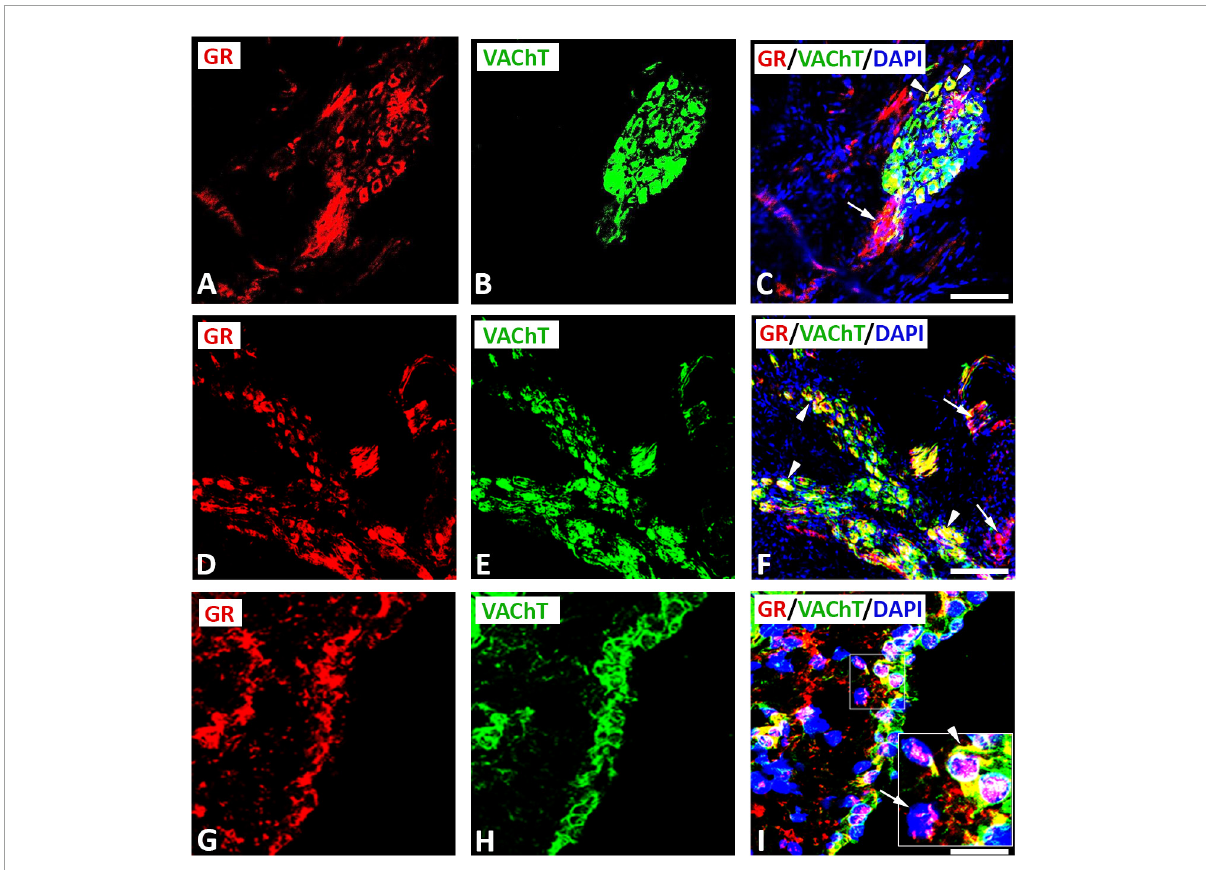
FIGURE2 Confocal microscopy of GR (A,D,G) ( red fluorescence ) and parasympathetic neuronal marker VAChT (B,E,H) ( green fluorescence ) double immunofluorescence in intracardiac ganglia (A–I) . (A–F) Show GR co-expressed with VAChT ( yellow fluorescence ) in large diameter neuronal soma (arrowhead), however, cluster of small diameter neuronal somata expressed GR only (arrow). (G–I) Higher magnification of gelatin-embedded transverse sections of atria (10 µ m thickness). Note a clear localization of GR immunoreactivity with VAChT-immunoreactive neuronal soma; however, some neurons expressed GR or VAChT only. The insert in (I) represents a higher magnification of a selected area showing GR expression in a nucleus (arrowhead) or at the periphery of neuron (arrow). (C,F,I) Show DAPI nuclear staining ( bright blue ). Bar: (A–I) = 60 µ m; a higher magnification of (I) = 120 µ